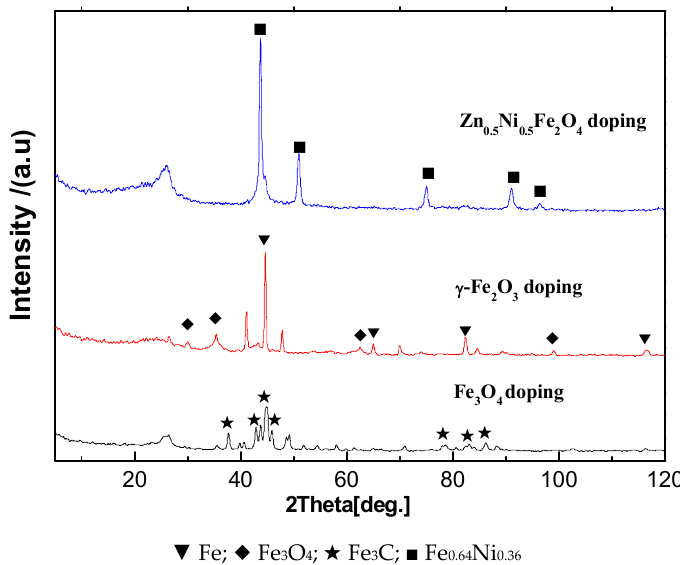
Figure 6. XRD patterns of Fe series magnetic nanoparticle/C hybrid membranes [65].